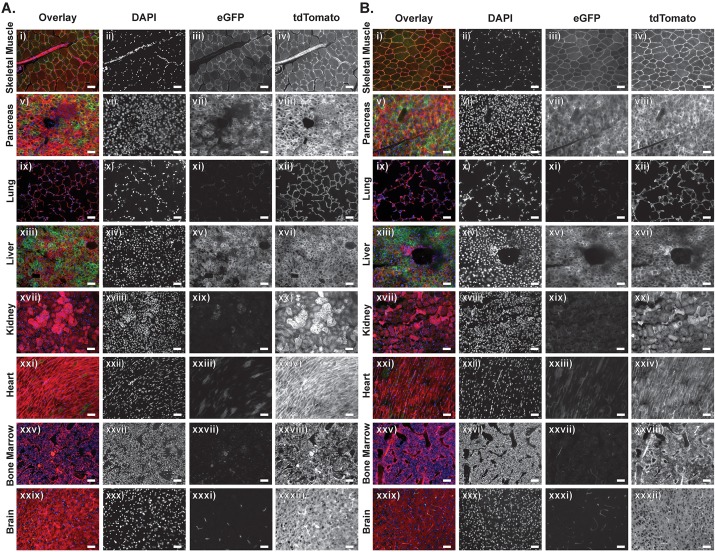
Characterization of tamoxifen-independent Cre-ERT2 activity in Col1a1FRT-Cre-ER-T2-FRT mice. (A) Immunofluorescence of tissues from 4-month-old Col1a1FRT-Cre-ER-T2-FRT; Rosa26mTmG/+ mice (n=2) without tamoxifen treatment show time- and tissue-dependent leakiness of Cre-ERT2, with more widespread eGFP expression in the skeletal muscle (Aiii), pancreas (Avii) and liver (Axv). (B) Immunofluorescence of tissues from 6-month-old Col1a1FRT-Cre-ER-T2-FRT; Rosa26mTmG/+ mice (n=3) without tamoxifen treatment show increased time- and tissue-dependent leakiness of Cre-ERT2, with more widespread eGFP expression in the skeletal muscle (Biii), pancreas (Bvii) and liver (Bxv). The skeletal muscle and the pancreas show the most apparent increase in eGFP expression from 4 to 6 months. Scale bars: 50 µm.